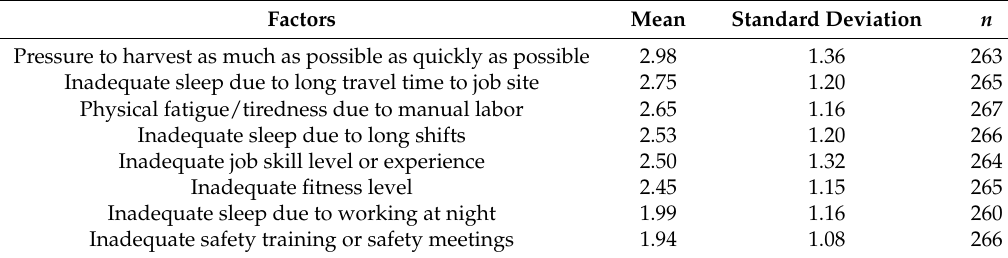
Table 4. Survey respondents’ evaluation of how common it is for select factors related to structural conditions to contribute to injury incidents on logging operations in the Inland Northwest, average of 1 to 5 scale (1 = not at all common, 5 = very